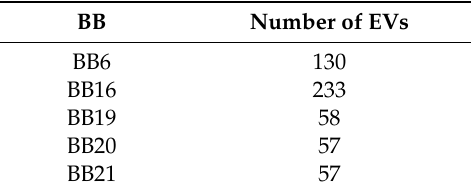
Table 3. Number of EVs per each